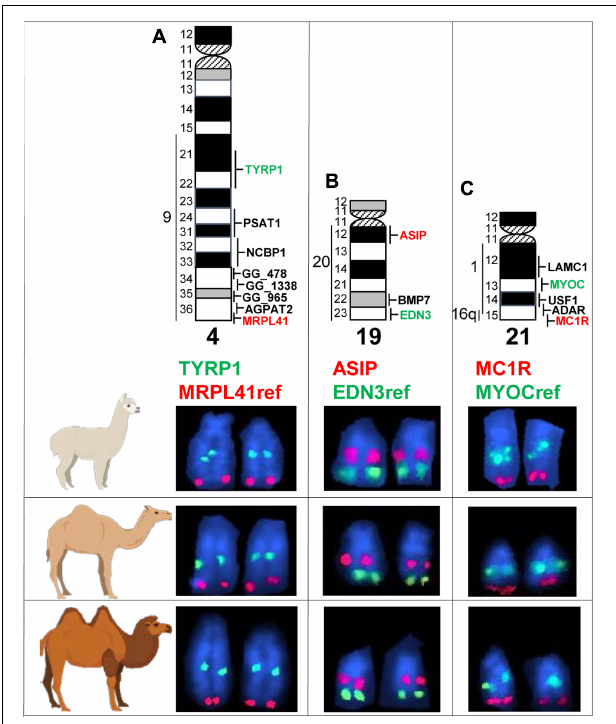
FIGURE 4 | Comparative FISH mapping. Comparative mapping of TYRP1 (A) , ASIP (B) , and MC1R (C) in alpaca, dromedary, and Bactrian camel chr4, chr19, and chr21, respectively. Chromosome ideograms with all mapped markers (Avila et al., 2014a) are shown at the top. Vertical lines with numbers to the left of chromosome ideograms indicate homology segments to human chromosomes. Ref, reference gene for chromosome identification. Green and red font colors for coat color genes and reference genes correspond to the green and red FISH signals in partial microscope images below